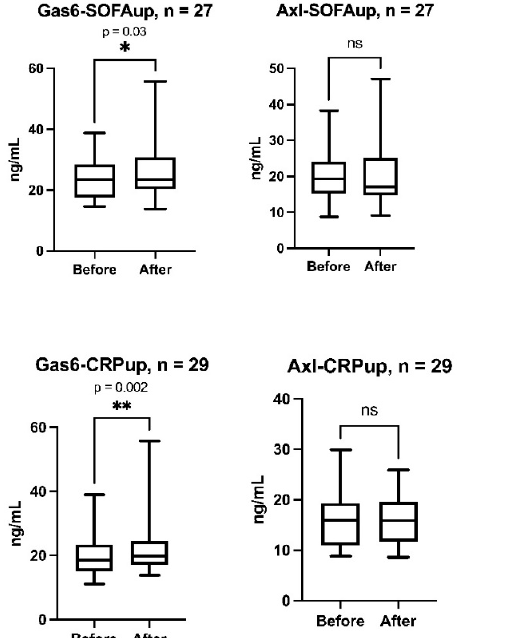
Figure 1. ( a ) Boxplots of growth arrest-specific gene 6 protein (Gas6) plasma concentration changes before and 24 h after vitamin K1 administration, boxplot analyses and individual patient ( n = 52) changes. ( b ) Boxplots and individual patient ( n = 52) plasma concentration changes of soluble Axl receptor (Axl) before and 24 h after vitamin K1. ** ( p = 0.007) and ns (no significant change).